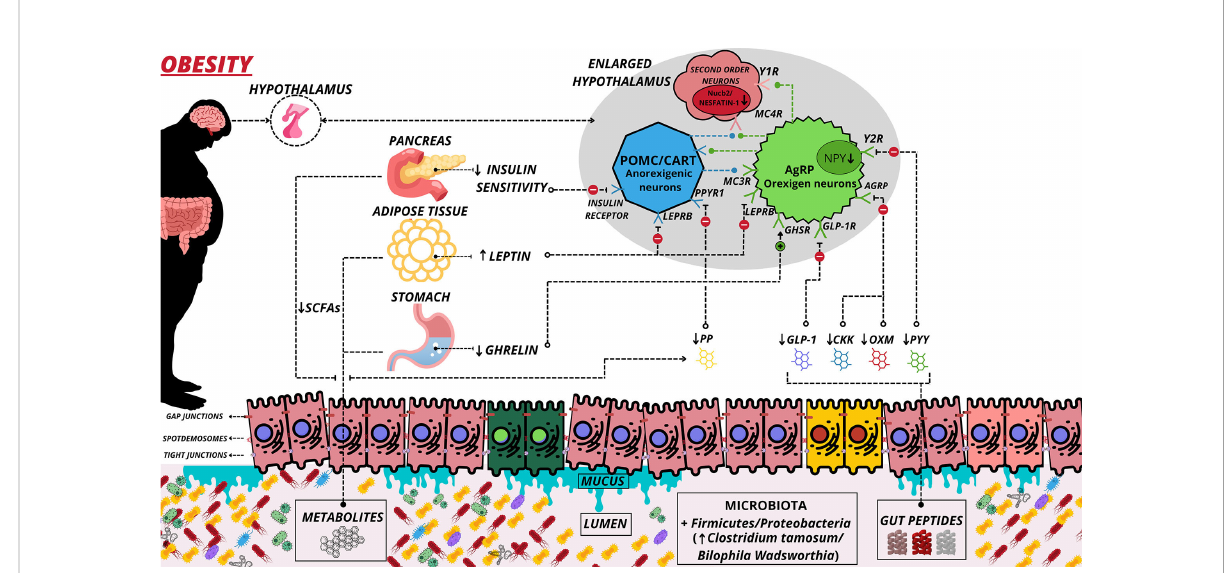
FIGURE 2 Alteration of the microbiota-gut-brain axis in obesity. Main hormonal changes derived from obesity. Obesity leads to damage to epithelial cells and damage to gap junctions of these cells, which allows greater permeability of undesirable substances to the systemic circulation. A decrease in mucus and decline in the interactions of some peptides/hormones with their respective receptors also occurs. Red cells illustrate in fl amed cells. ( ↑ ) Increase Secretion and Greater; ( ↓ ) Decrease Secretion and Decline; ( ⊕ ) Positive interaction; ( ⊖ ) Negative Interaction; ( ⊘ ) Non Interaction; SCFAs, Short-Chain Fatty Acid; PYY, Peptide YY; OXM, Oxytomodulin; PPYR1, Pancreatic Polypeptide Receptor 1; PP, Pancreatic Polypeptide; GLP-1, Glucagon Like Peptide-1; GLP-1R, Glucagon Like Peptide-1 Receptor; LEPRB, Leptin Receptor Long Isoform;